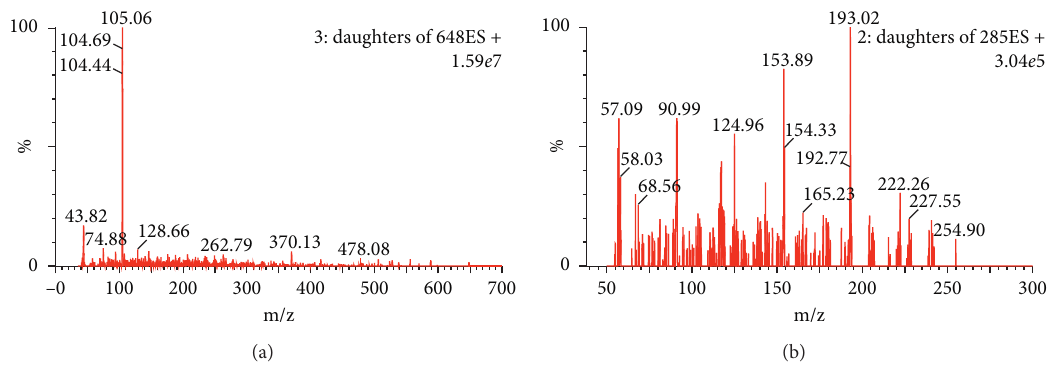
Figure 1: Mass spectrum of 10-hydroxy mesaconitine (a) and IS